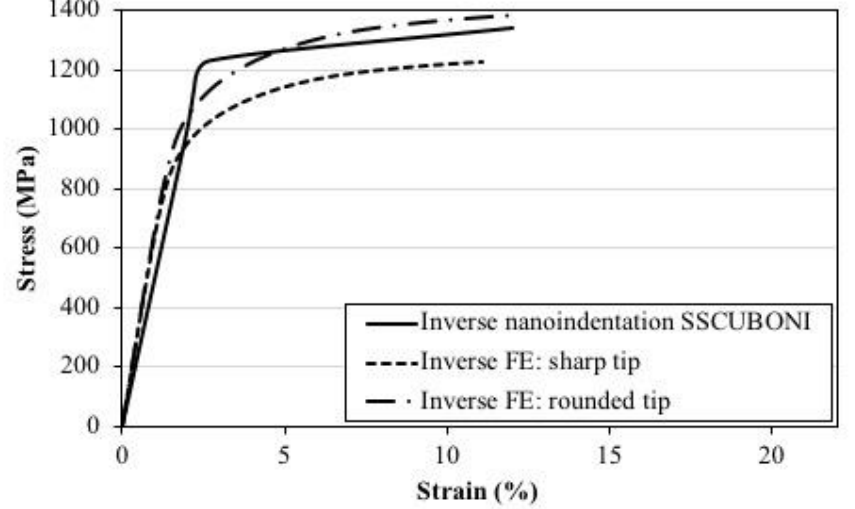
Figure 13. Comparison of the S-S curves of the experimental compression test with the corresponding inverse numerical nanoindentation results and the inverse SSCUBONI-based experimental test for the cW-Cu specimens.